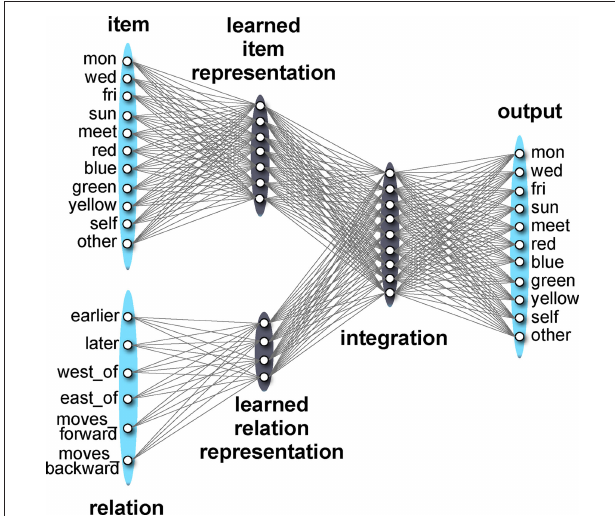
Figure 1 | Diagram of network